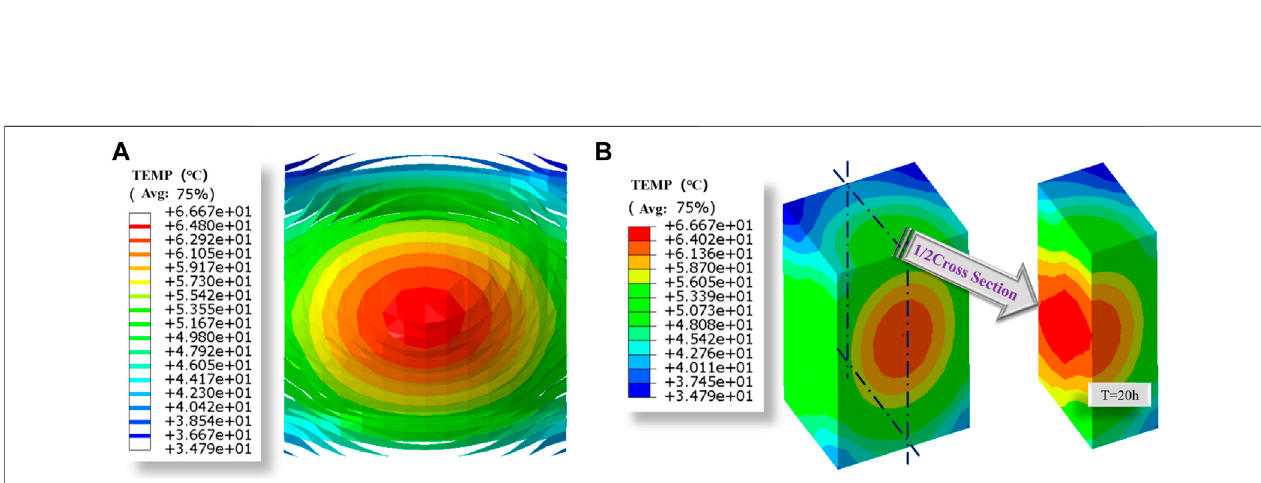
FIGURE 13 | Spatial distribution of the heat of hydration temperature fi eld of UHPC at 20 h. (A) Isothermal surface at 20 h. (B) Temperature distribution at 20 h.